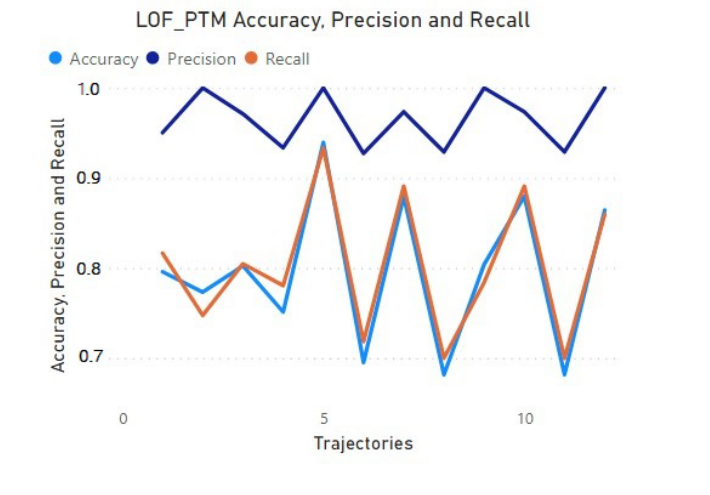
Figure 9. LOF performance for the PTM dataset: precision, recall, and accuracy.